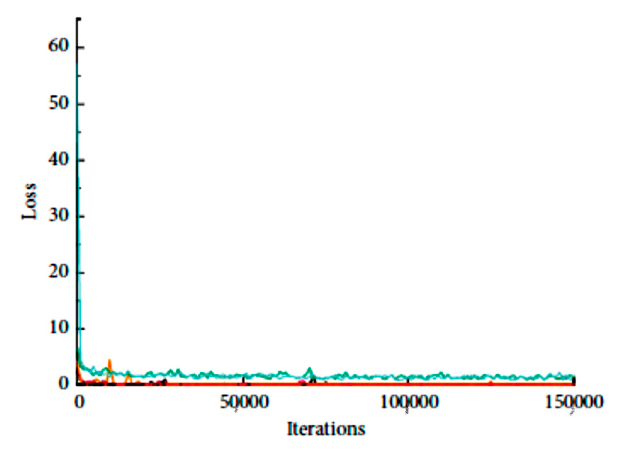
Figure 6. Loss of dataset during training progress.